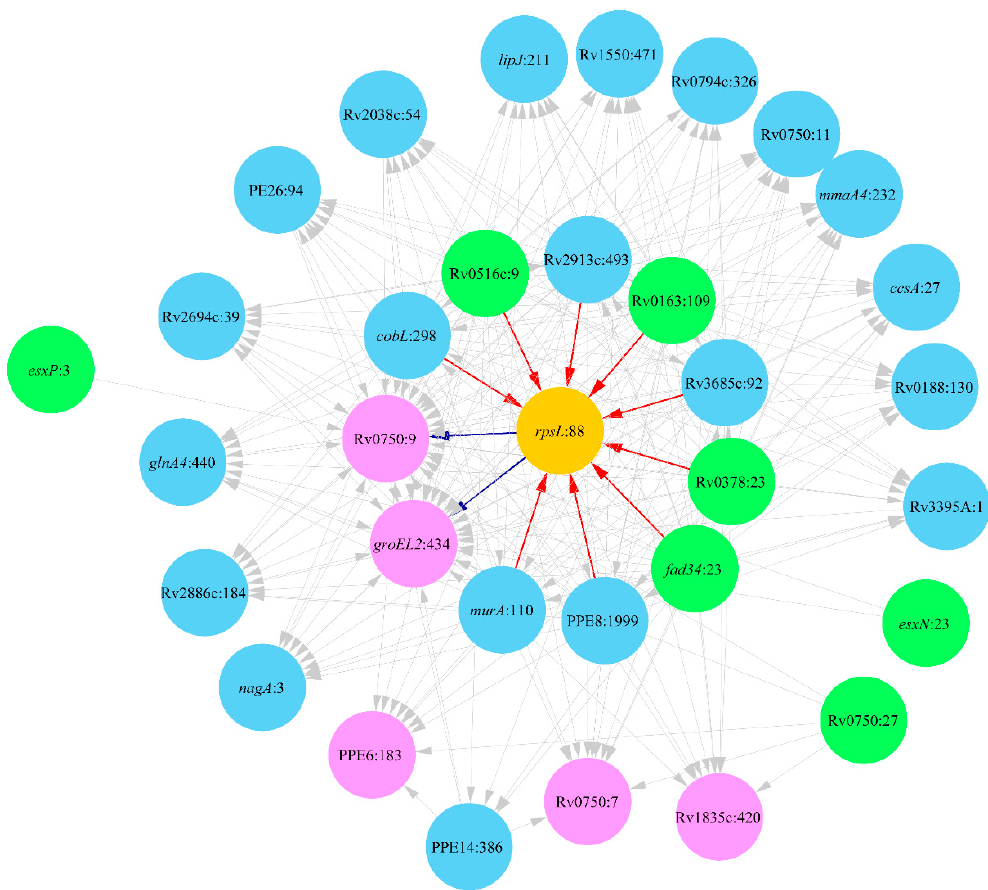
Figure 4. Network of DR-associated mutations in the clade Ural (Lineage 4.2). Polymorphic loci are shown as nodes titled by the respective gene name and the polymorphic codon number following the colon. DR mutation rpsL :88 is depicted by an orange color. Nodes linked exclusively by outgoing edges (prerequisite mutations) are shown in green and those linked exclusively by incoming edges (final and compensatory mutations) are shown in pink, while intermediate mutations are shown in blue. Arrows show relations between prerequisite and subordinate mutations, which in the case of direct association with the DR mutation are highlighted by red and blue colors, respectively.